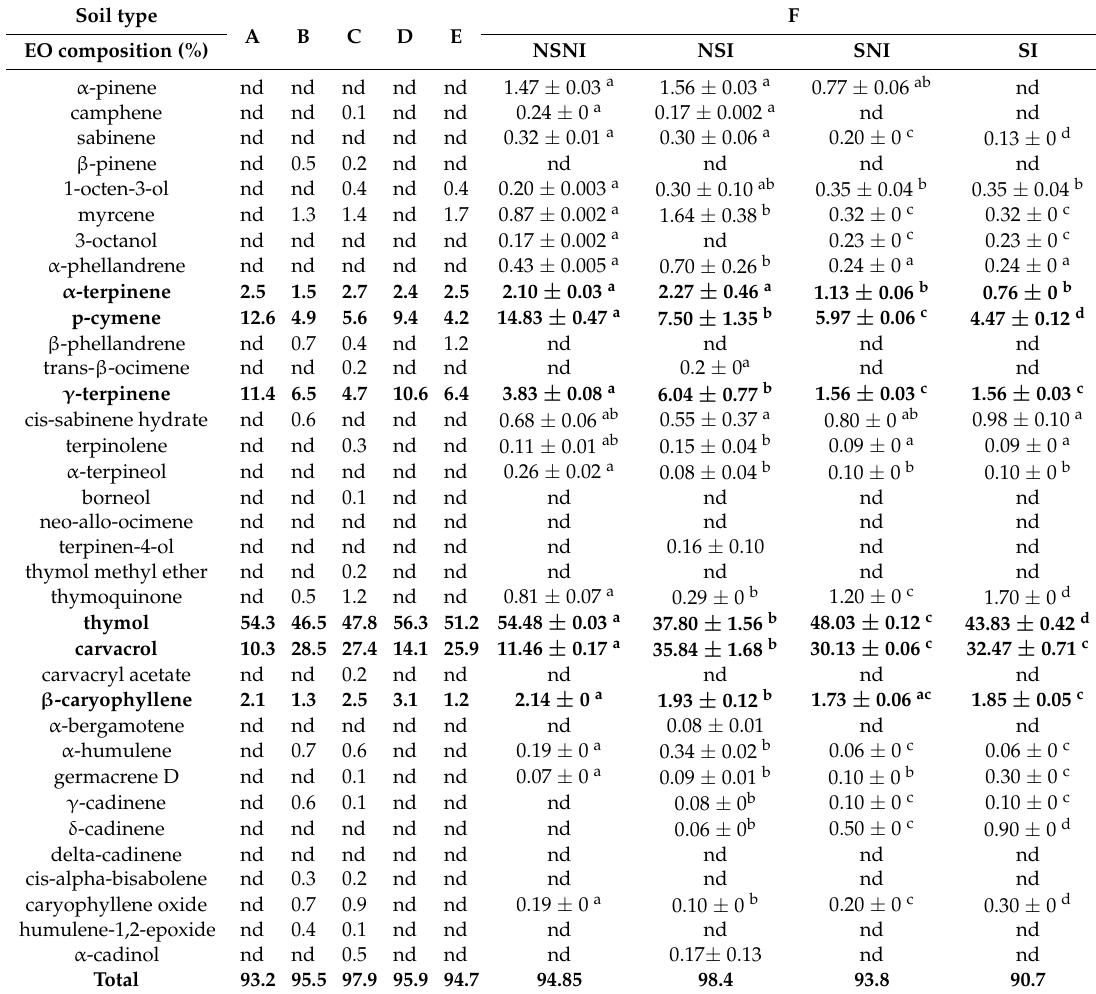
Table 3. Chemical composition of Origanum syriacum essential